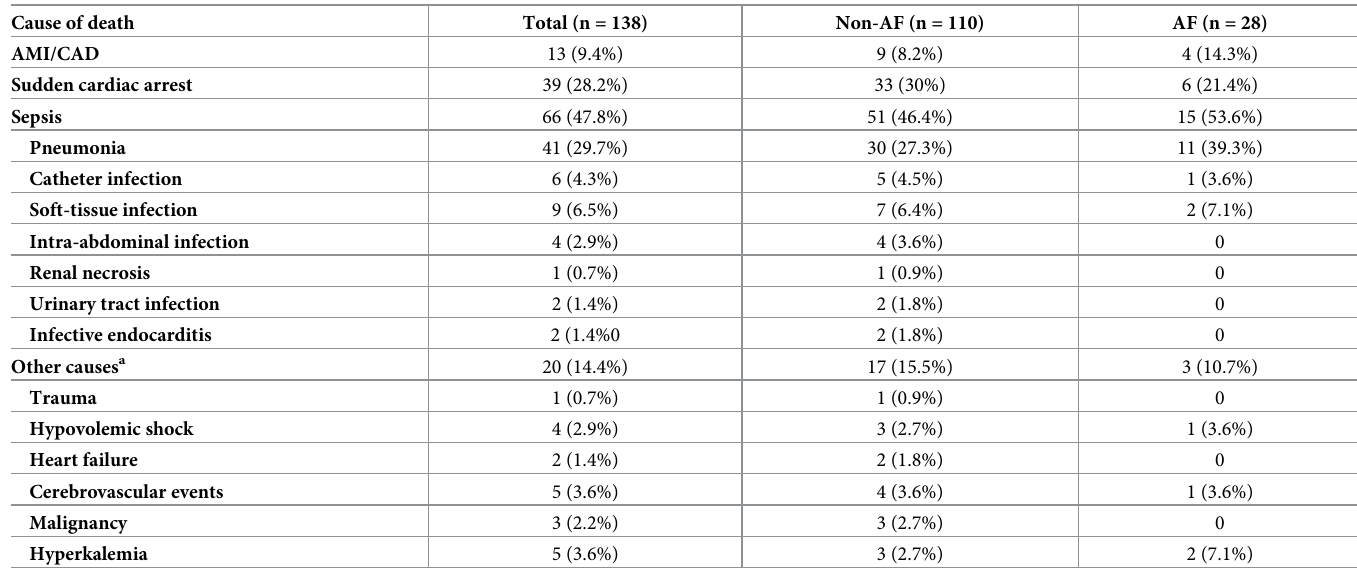
Table 4. Causes of death in patients on maintenance